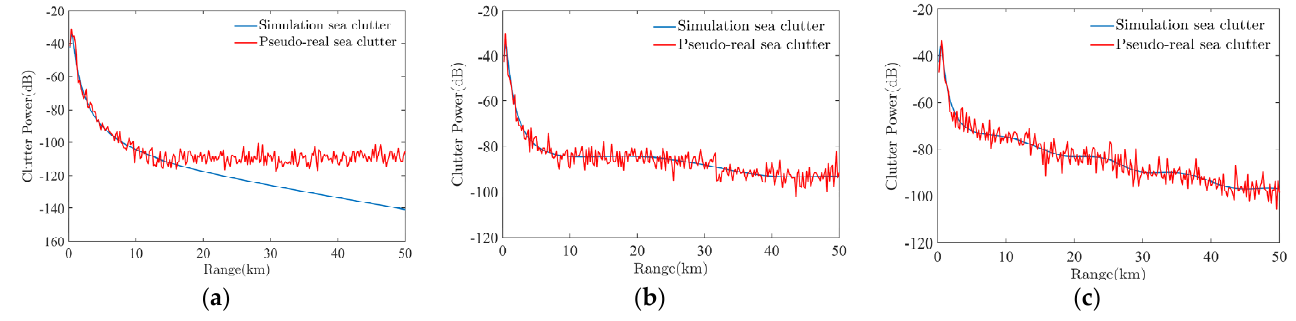
Figure 4. Simulation clutter power and pseudo − real sea clutter for different EDHs: ( a ) EDH = 10 m; ( b ) EDH = 20 m; ( c ) EDH = 30 m.